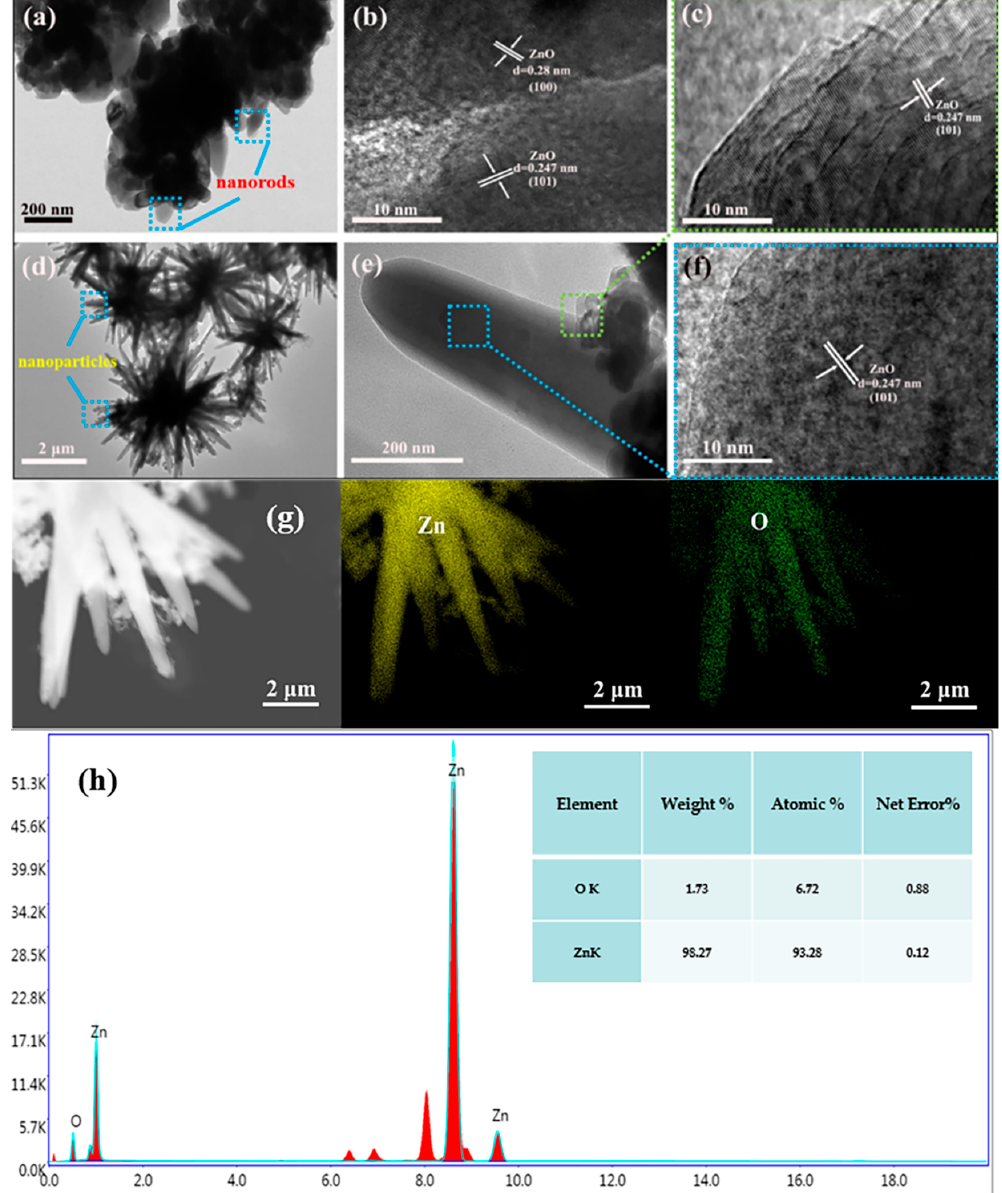
Figure 5. TEM images of as-prepared samples: ( a ) ZnO HS1 with low magnification, ( b ) ZnO HS1 with high magnification, ( d ) ZnO HS2 with low magnification, ( e ) ZnO HS2 with high magnification and ( c , f ) HRTEM images of the nanoparticle and nanorod on the ZnO HS2, ( g ) STEM mapping image of ZnO HS2 material and ( h ) EDX analysis of the ZnO HS2